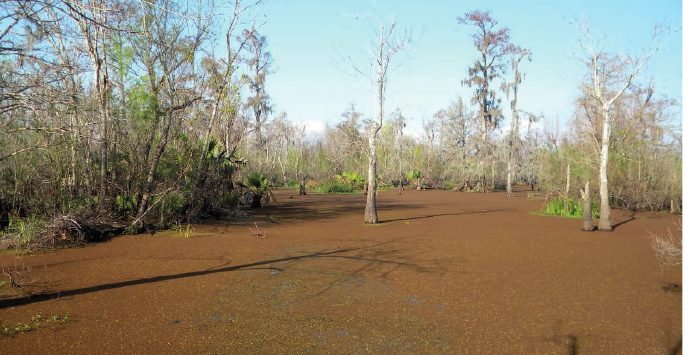
Fig. 2 WMA 1 coring site. The core was extracted from the bottom of a small pothole pond in a Taxodium